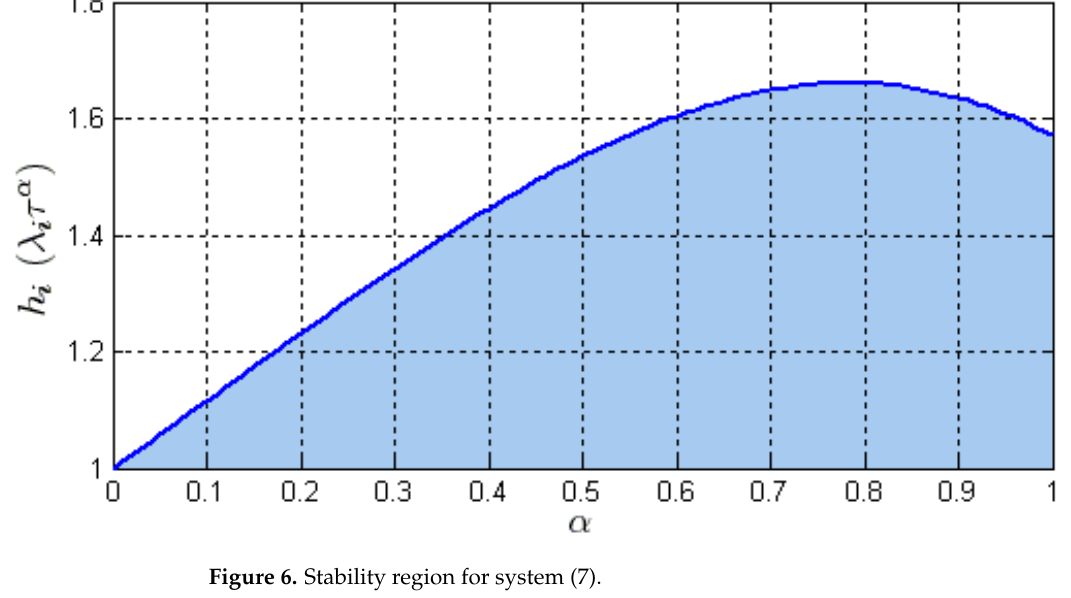
Figure 6. Stability region for system (7).